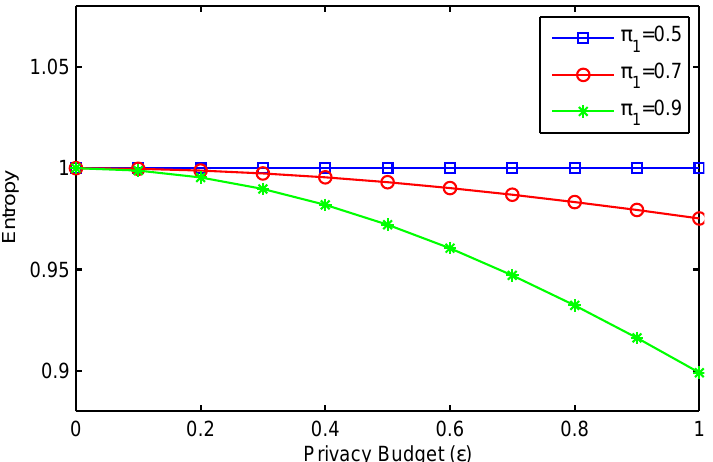
Figure 9. Entropy of output of bivariate randomized response mechanism.